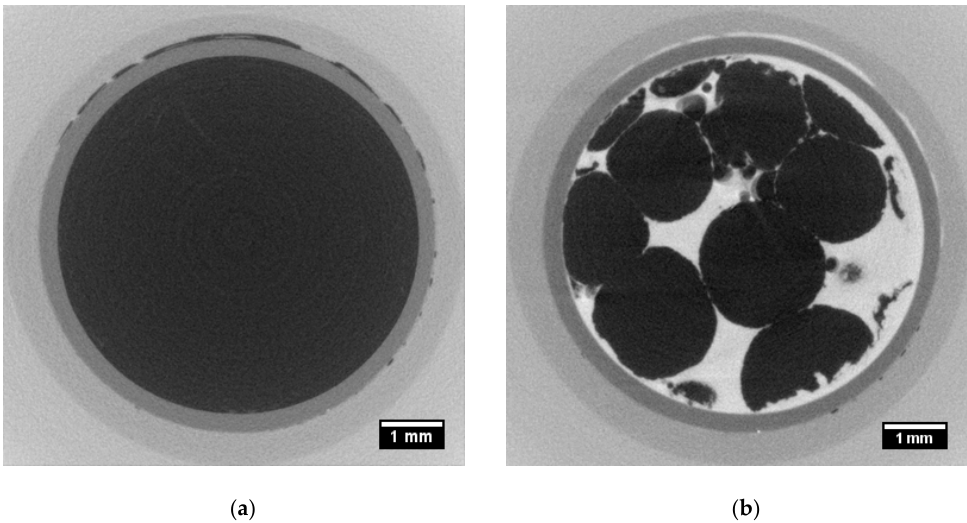
Figure 3. Tomographic slice of the uncompressed sample ( a ) before saturation and ( b ) after saturation.